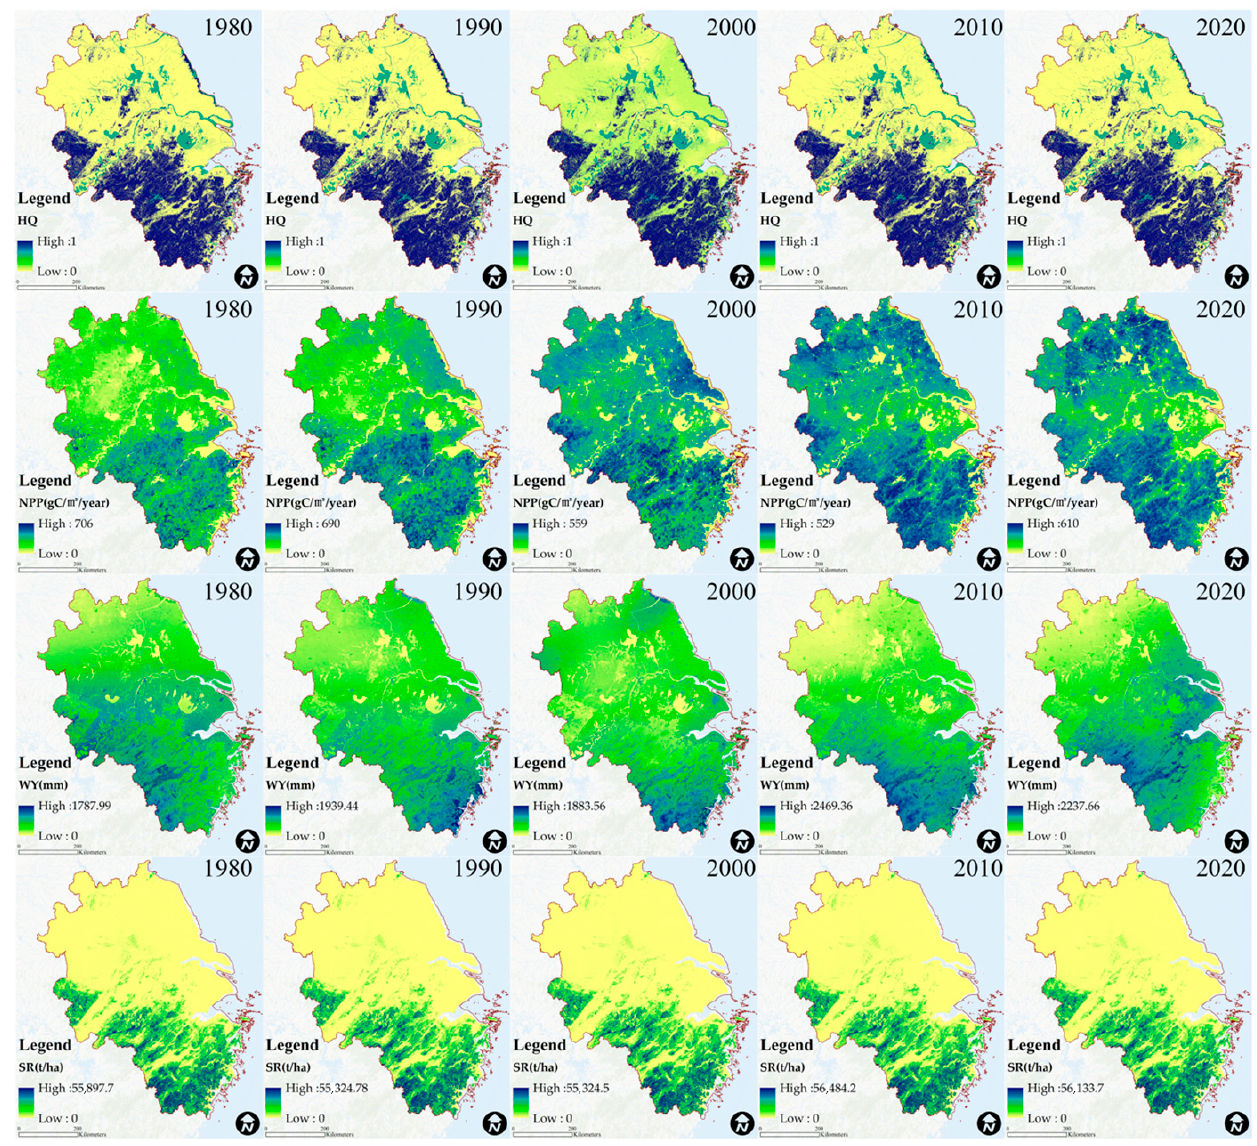
Figure 5. Distribution of ecosystem service pa tt erns in the Yang tz e River Delta from 1980 to 2020.